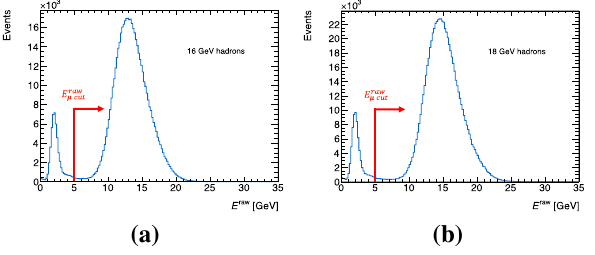
Fig. 5 Distributions of the energy E raw in GeV measured in the calorimeter modules in the case of particle beam energies equal to 16 GeV ( a ) and 18 GeV ( b ). The events were selected applying the selec- tion criteria up to Selection 2 (Table 2). The muons and spurious events were rejected in the analysis requiring E raw larger than E raw μ cut = 5 GeV, as shown in the histograms